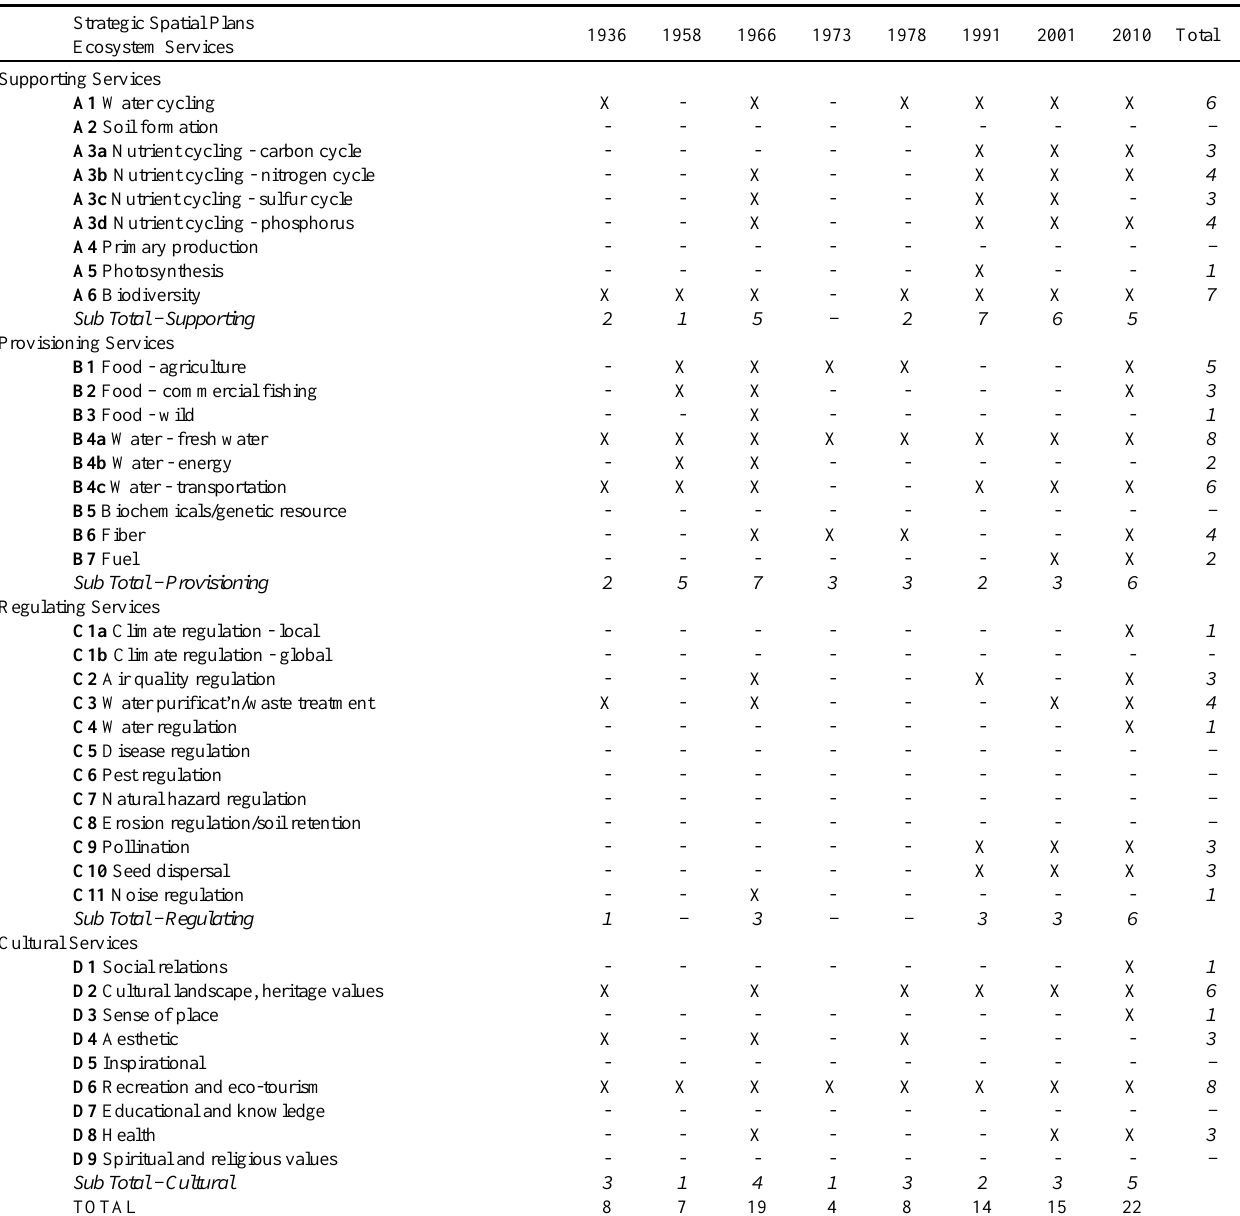
Table 2 . Ecosystem services addressed in Stockholm's strategic spatial plans Strategic Spatial Plans Ecosystem